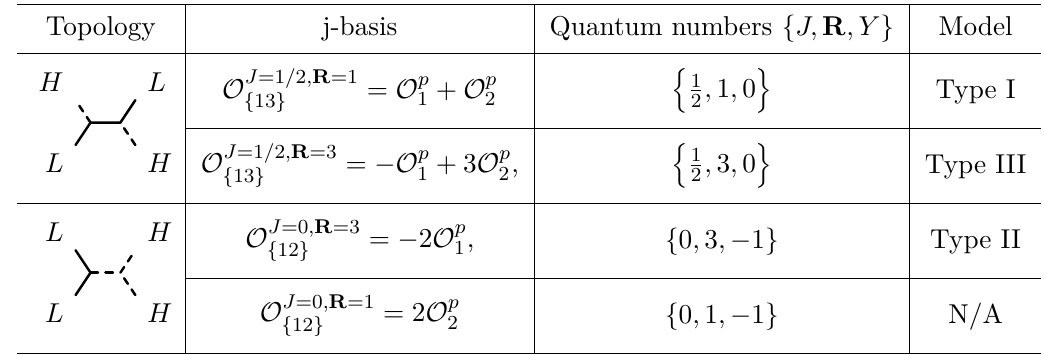
Table 11 . The complete j-basis for the Weinberg operator LLHH in two different partitions. Here three UV resonances correspond to the three types of the seesaw models. The last one vanishes because of the repeated field in the operator